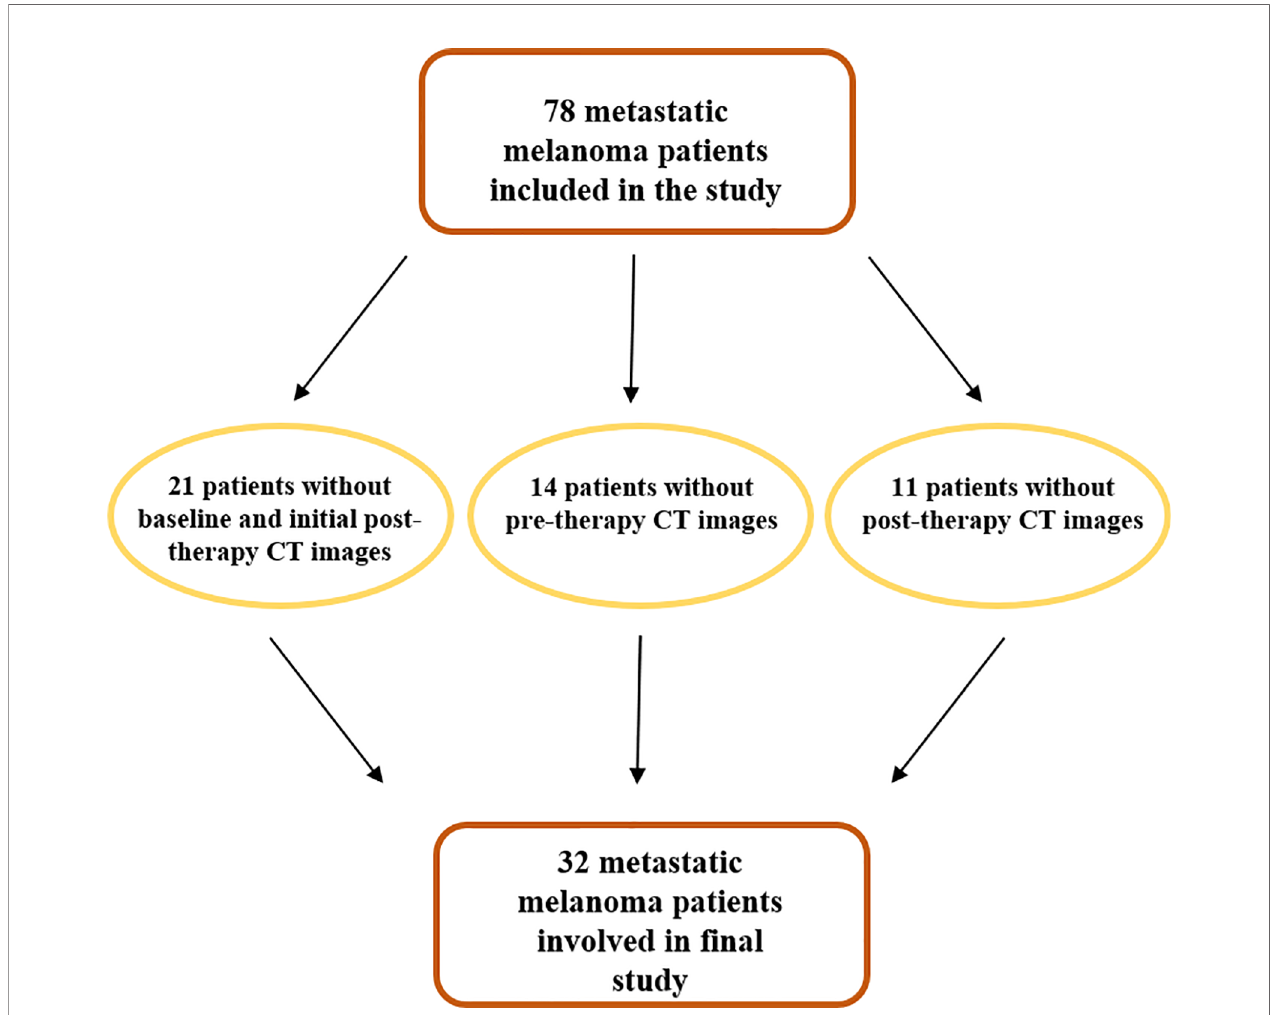
FIGURE 1 | Schematic characteristics of patients enrolled in the